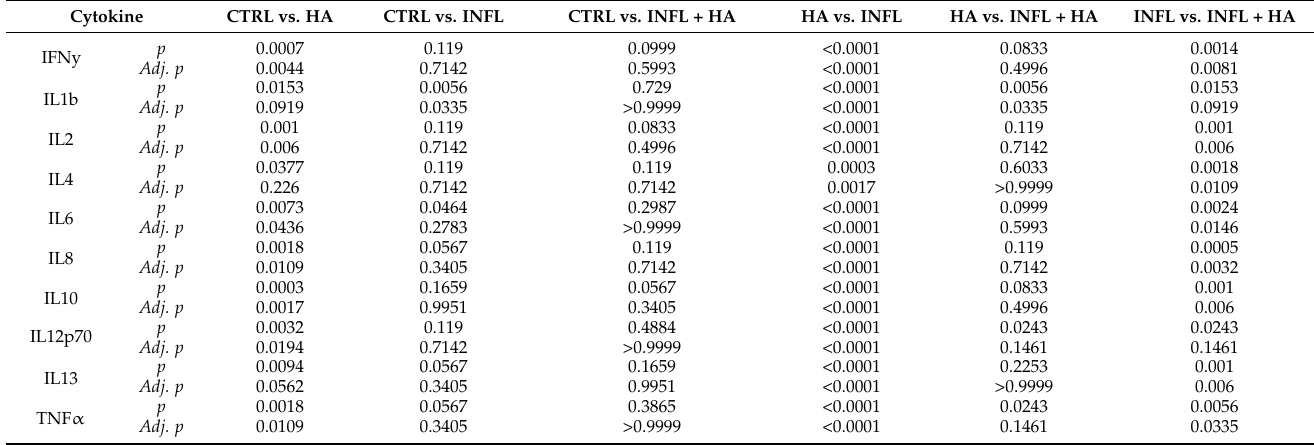
Table 1. p -values are given as the result of a Friedman test followed by post-hoc Dunn’s test without correction ( p ) and with correction ( adj. p ) comparing the mean cytokine concentrations of 10 biological repeats. CTRL = Control medium, INFL = Control medium and inflammatory mix, HA = medium containing 100 mM acetate, INFL + HA = medium containing 100 mM acetate and inflammatory